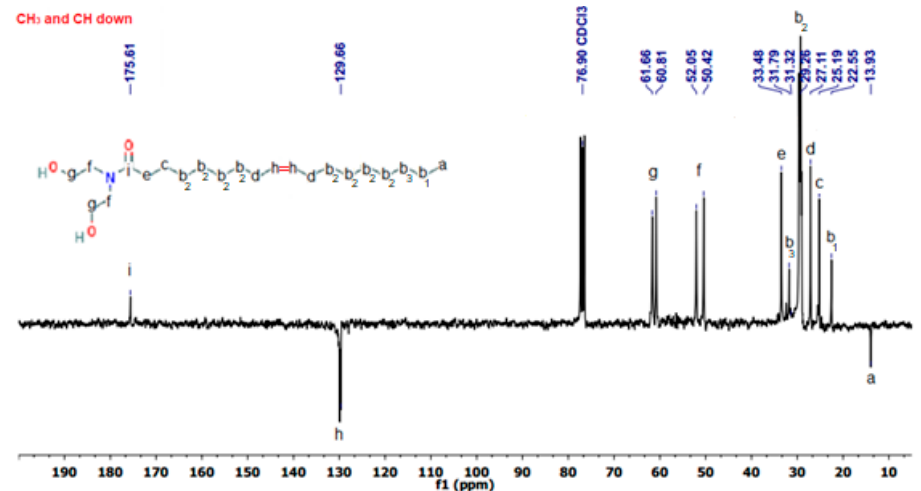
Figure 5. 13 C NMR-APT spectrum of OADA.